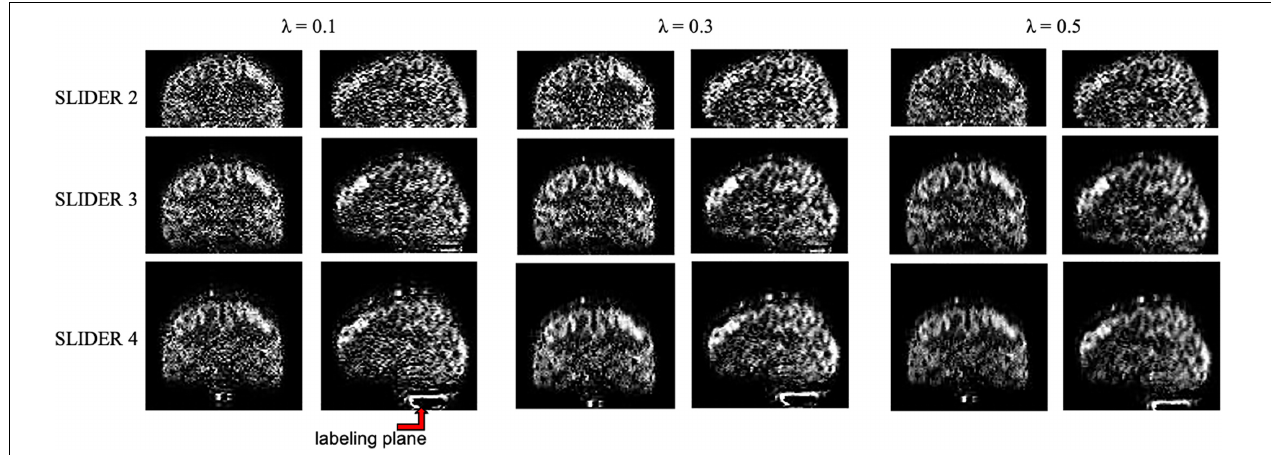
FIGURE 4 | SLIDER super-resolution reconstructed image in the sagittal and coronal direction. SLIDER2 has a brain coverage of 96 mm, SLIDER3 has a brain coverage of 144 mm, and SLIDER4 has a brain coverage of 192 mm. SLIDER4 can reach the labeling plane, as marked by the red arrow. Larger regularization parameters will lead to more spatial blurring.